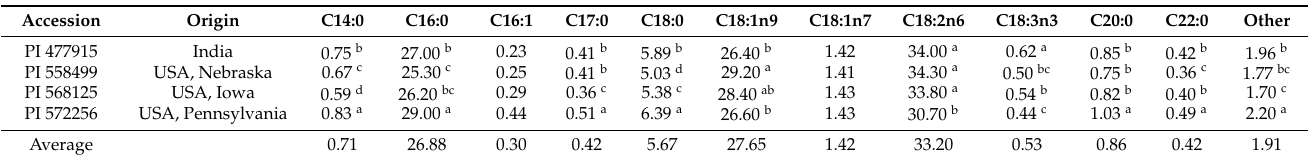
Table 3. Mean values of three replications of the fatty acid profile (g/100 g) * in the four accessions of A. hypochondriacus